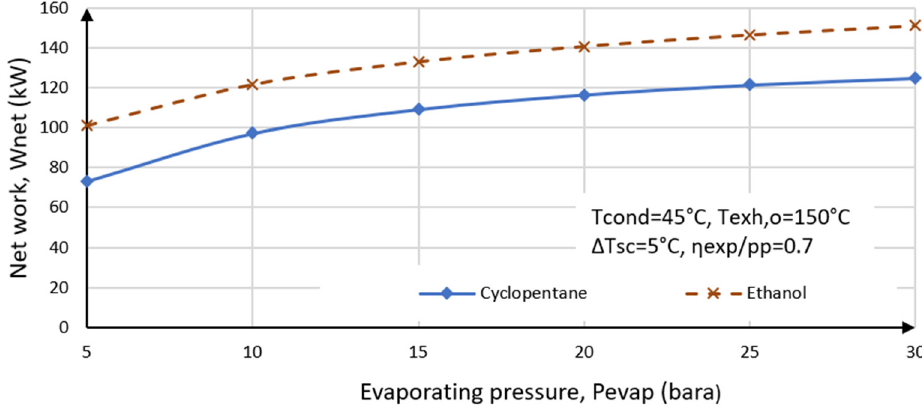
Figure 13. Net work against evaporating pressure.